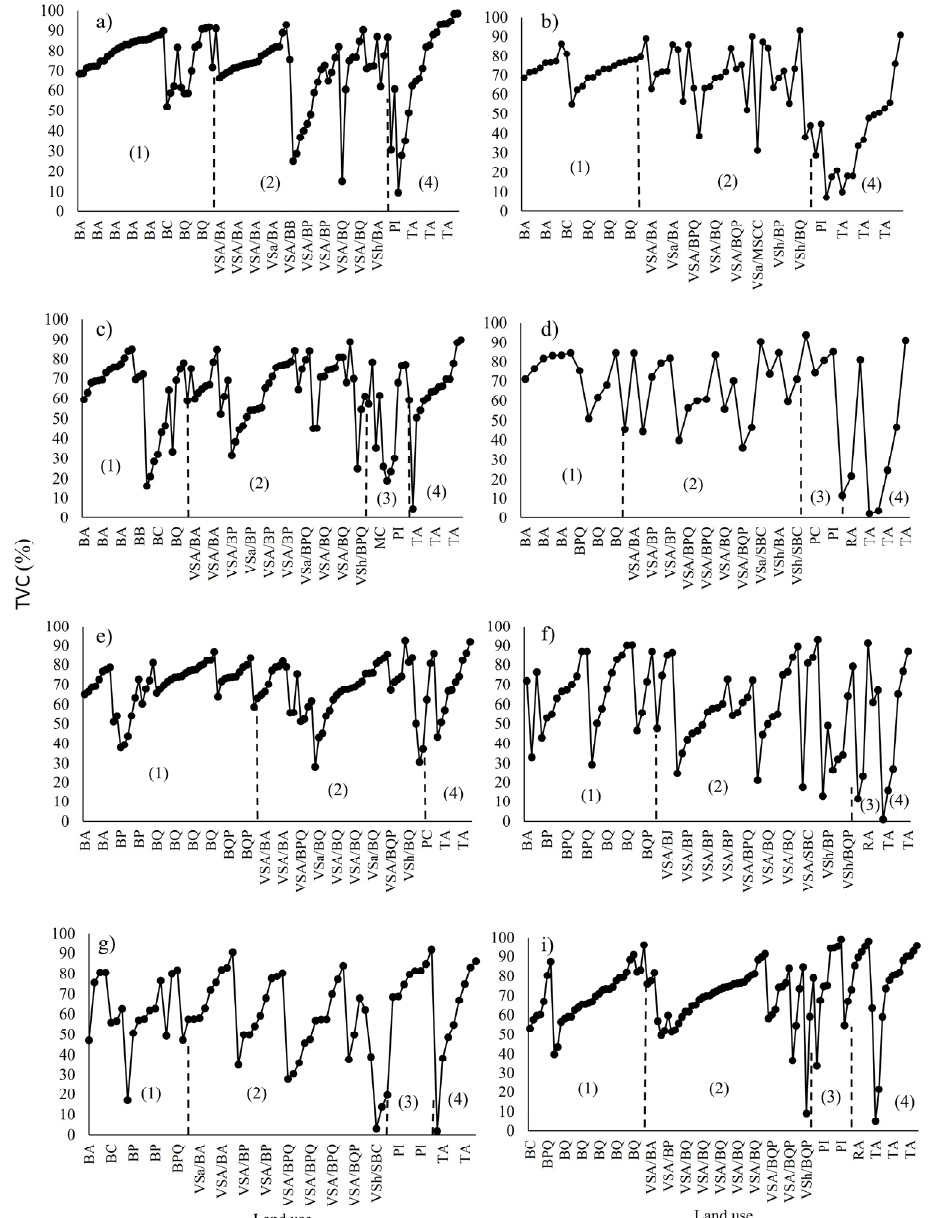
Figure 9. Average total vegetation cover by land use in the eight regions of the State of Mexico: ( a ) Toluca Region; ( b ) Zumpango Region; ( c ) Texcoco Region; ( d ) Tejupilco Region; ( e ) Atlacomulco Region; ( f ) Coatepec Region; ( g ) Valle de Bravo Region; ( i ) Jilotepec Region. (1) Mature forest; (2) disturbed forest; (3) grassland; (4) agricultural area.